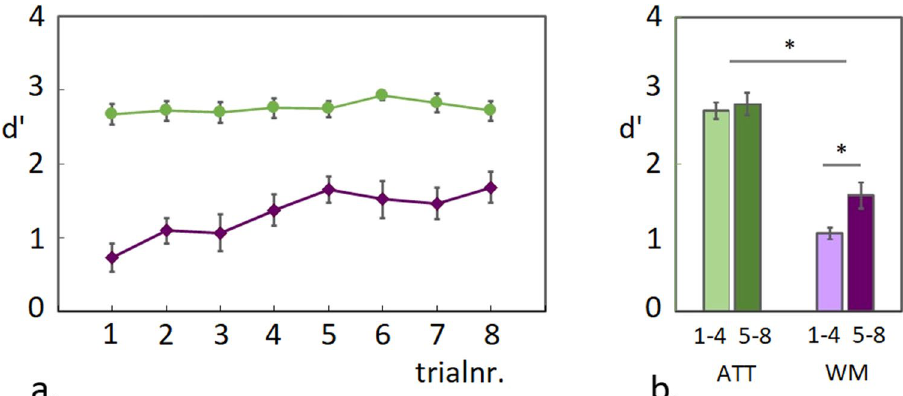
Figure 2. WM task accuracy scores. ( a ) Mean d’ scores during the ATT and WM conditions are plotted for 8 consecutive trials in a testing block. A gradual increase in accuracy during the WM condition reached a plateau around the fifth trial, while performance for the ATT condition was around ceiling throughout the testing block. ( b ) Plotted are the accuracy scores for both conditions, averaged across the first- and the second four